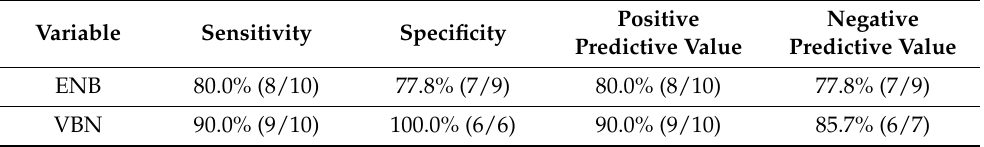
Table 3. Sensitivity and specificity of ENB versus